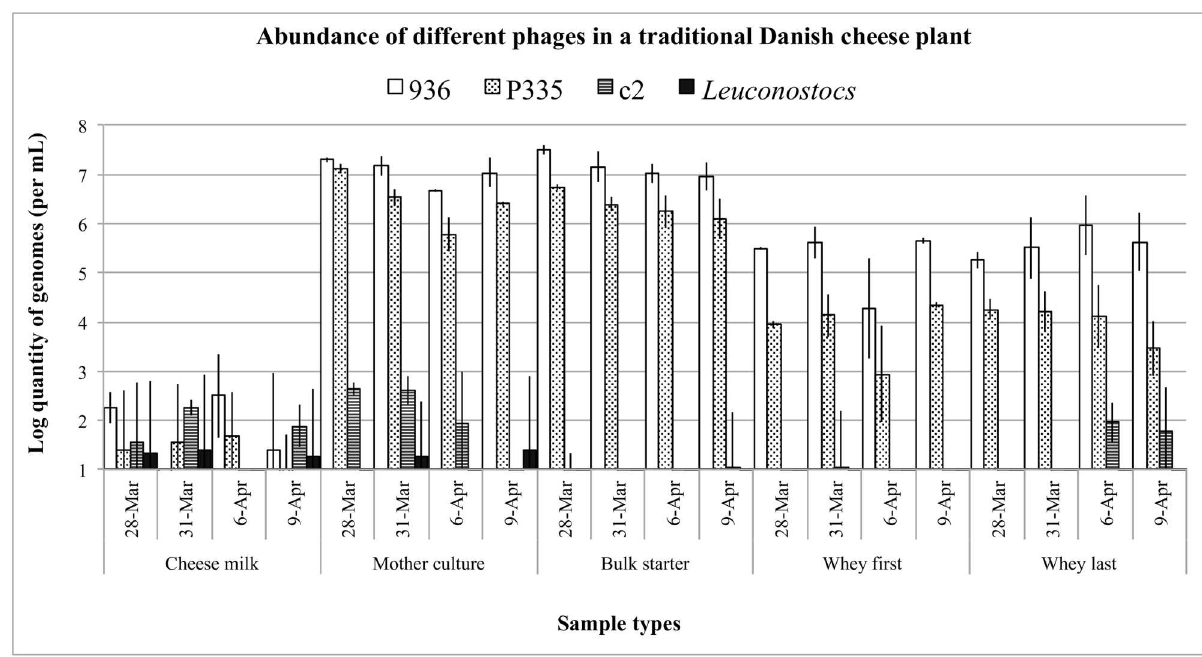
Fig 2. Quantities of L . lactis 936, P335, c2 and Leuconostoc groups of phages in a dairy plant. The quantity of phagegenomes detected in one mL of cheese milk, mother culture, bulk starter and first and last wheys on five representativeproduction days (on March and April, 2014) is shown. This was calculatedfrom (determinedas) the amount of genomesdetected in 1.25 μ l of 100-folddiluted phage DNA extract using HT-qPCR on the BioMark HD system.